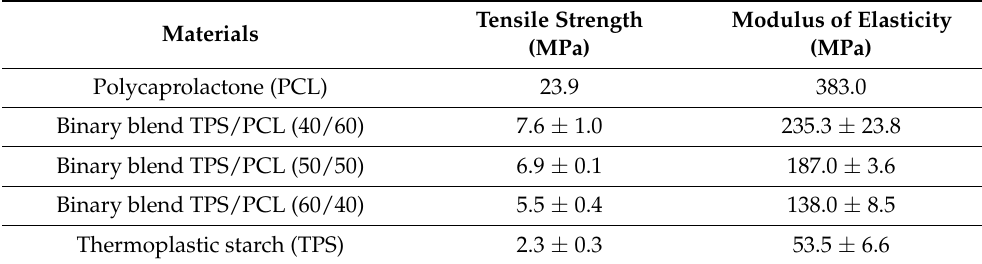
Table 5. Tensile mechanical properties for TPS, PCL, and TPS/PCL binary blends at 40/60, 50/50, and 60/40 ratios, stored at 54% relative humidity and 25 ◦ C for 17